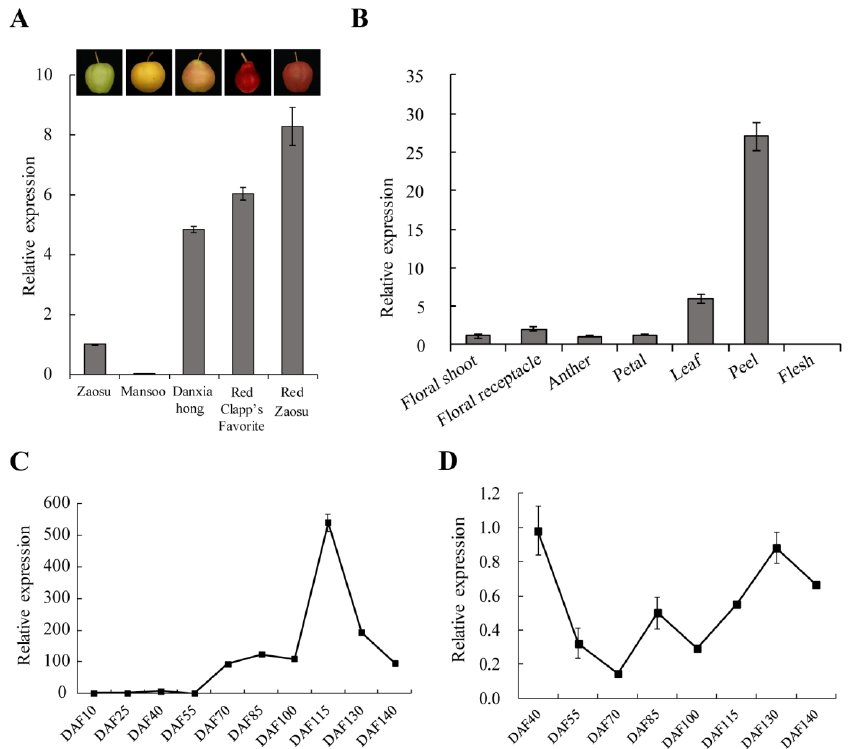
Figure 8. The transcript patterns of PcGST57 . ( A ) Transcript analysis of PcGST57 in different pears. Pears, including ‘Zaosu’, ‘Mansoo’, ‘Danxiahong’, ‘Red Clapp’s Favorite’, and ‘Red Zaosu’, with different colors were selected for analysis. ( B ) Transcript analysis of PcGST57 in various pear tissues of ‘Danxiahong’. Various pear tissues of ‘Danxiahong’, including floral shoot, floral receptacle, leaf, petal, and anther at 0 DAF, and peel, flesh of 100 DAF were sampled for transcript analysis. ( C ) Transcript analysis of PcGST57 in pear peels of ‘Danxiahong’ at different developmental periods. ( D ) Transcript analysis of PcGST57 in pear flesh of ‘Danxiahong’ at different developmental periods. PcTubulin was used as the internal control for gene expression analysis. All the data indicate means ± SD of three biological